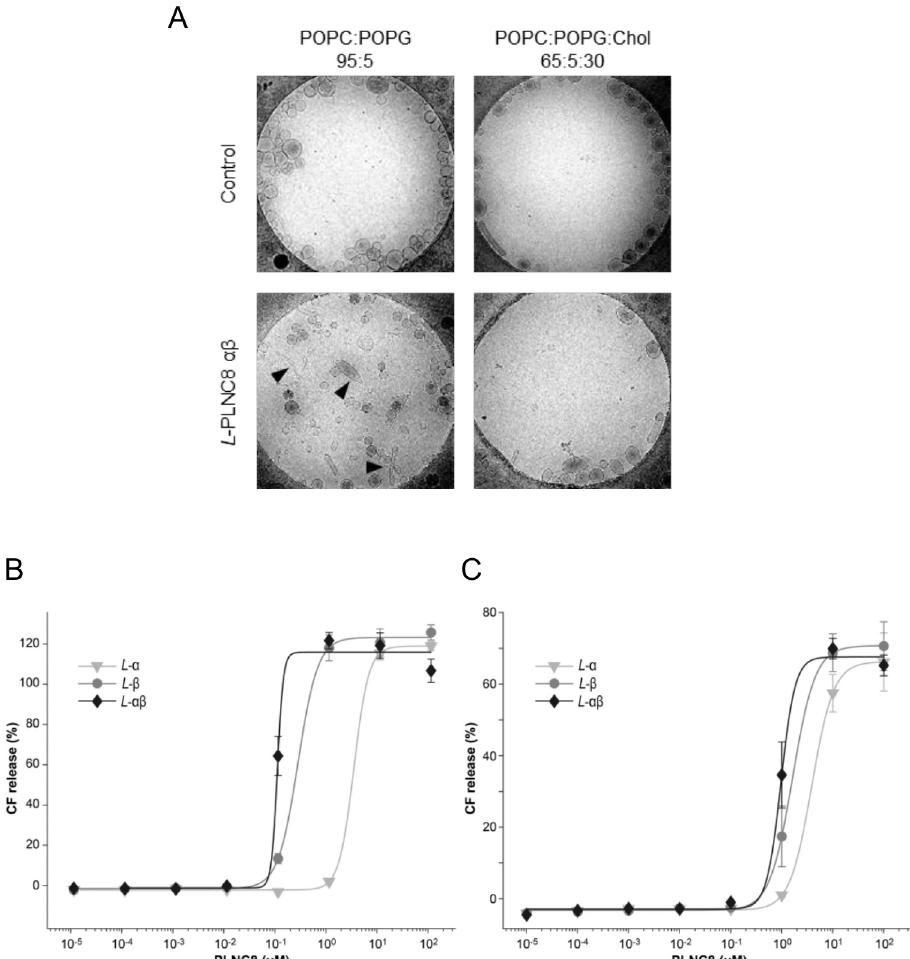
Fig 10. Cholesterol content, phospholipid composition, and total extracellular anionic charge of membranes reflect different viral lipid envelopes and their susceptibility to PLNC8 αβ . A - Cryo-EM of liposomes containing 5% phosphatidylglycerol, with or without 30% cholesterol, were either left untreated or exposed to L -PLNC8 αβ at a final concentration of 1 μ M for 2 min. Liposomes without cholesterol were deformed (black arrowhead) by the peptides and no longer associated with the positively charged carbon on the edges, indicating that the liposomes have lost their negative charge. B - Effects of the peptides L -PLNC8 α , L -PLNC8 β and L -PLNC8 αβ on ER-mimetic liposomes containing 81% POPC, 11% POPS and 8% cholesterol, and C - plasma membrane mimetic liposomes containing 70% POPC, and 30% cholesterol. The susceptibility of the phospholipid membranes of liposomes to PLNC8 αβ is dependent on the total anionic charge of the outer leaflet and cholesterol